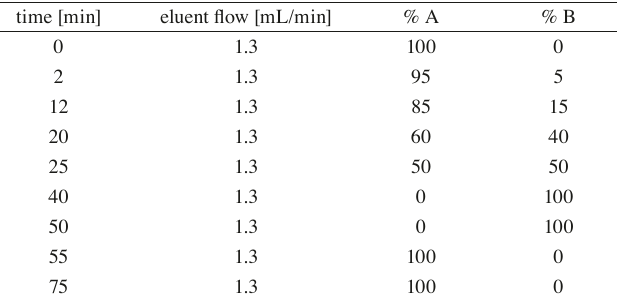
Tab. 1: HPLC gradient for analysis of amino